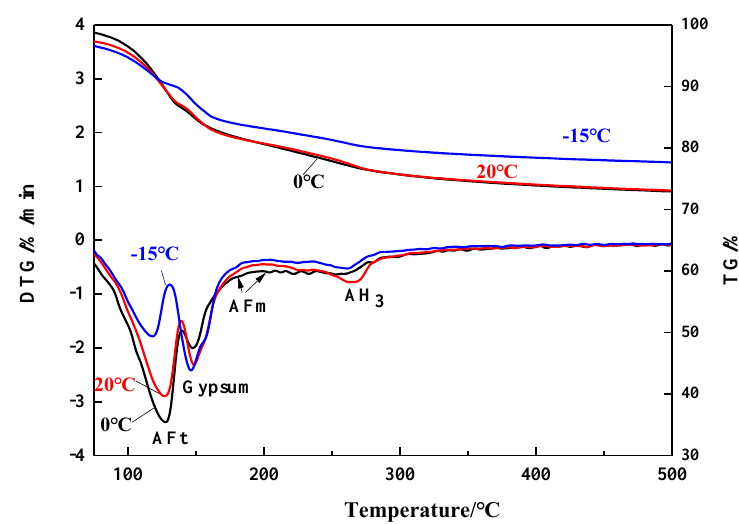
Figure 3. TG/DTG curves of samples hydrated for 28 days at different temperatures.